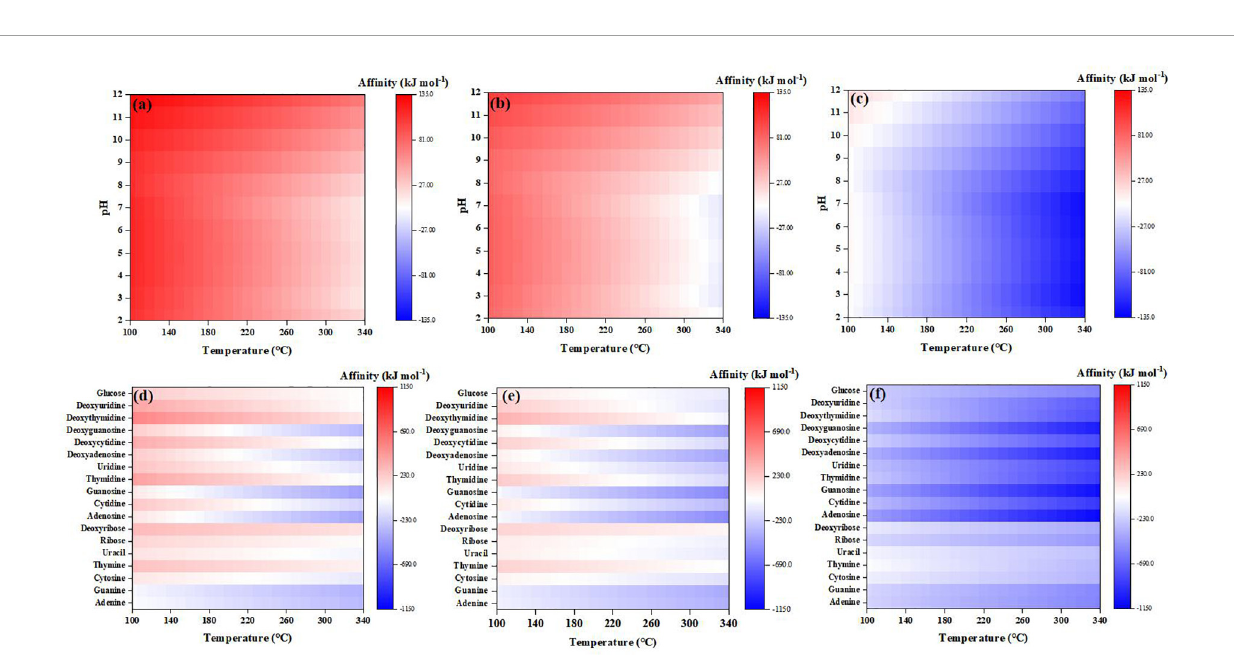
FIGURE9 Synthesis affinity of (a–c) glycine, (d–f) sugars, nucleobases, and nucleosides at different redox states [ (a,d) , FQI; (b,e) IW; (c,f) , FMQ] using CO 2 as the carbon